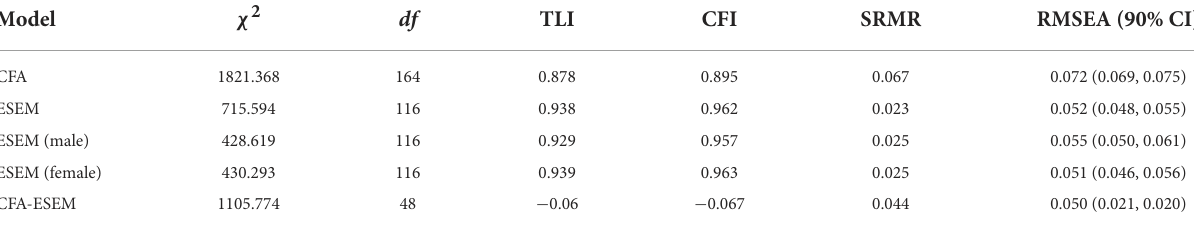
TABLE 2 Comparison of fitting indexes between CFA and ESEM.